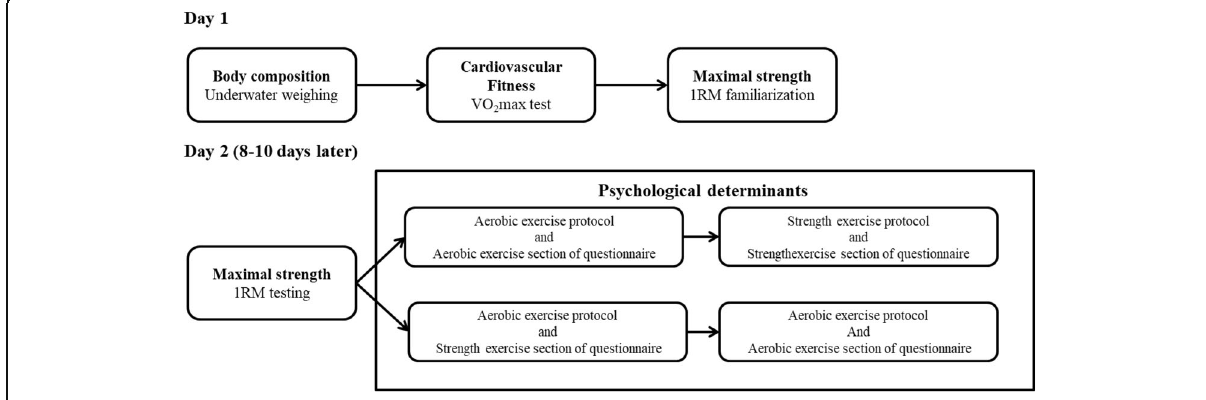
Fig. 1 Flowchart of the study